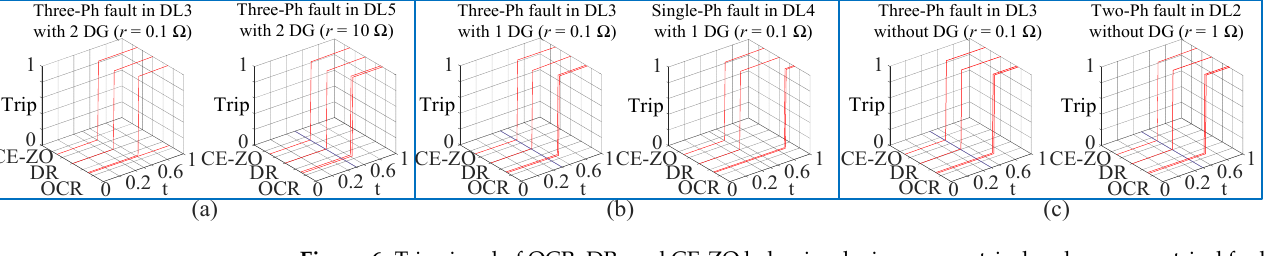
faults with different fault resistance ( a ) with two DGs, ( b ) with one DG, and ( c ) without DG.